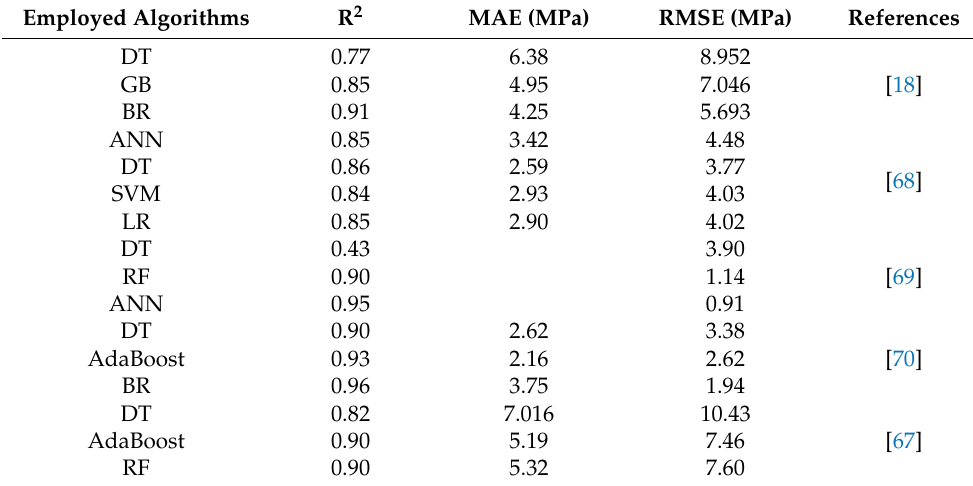
Table 3. Result comparison with published